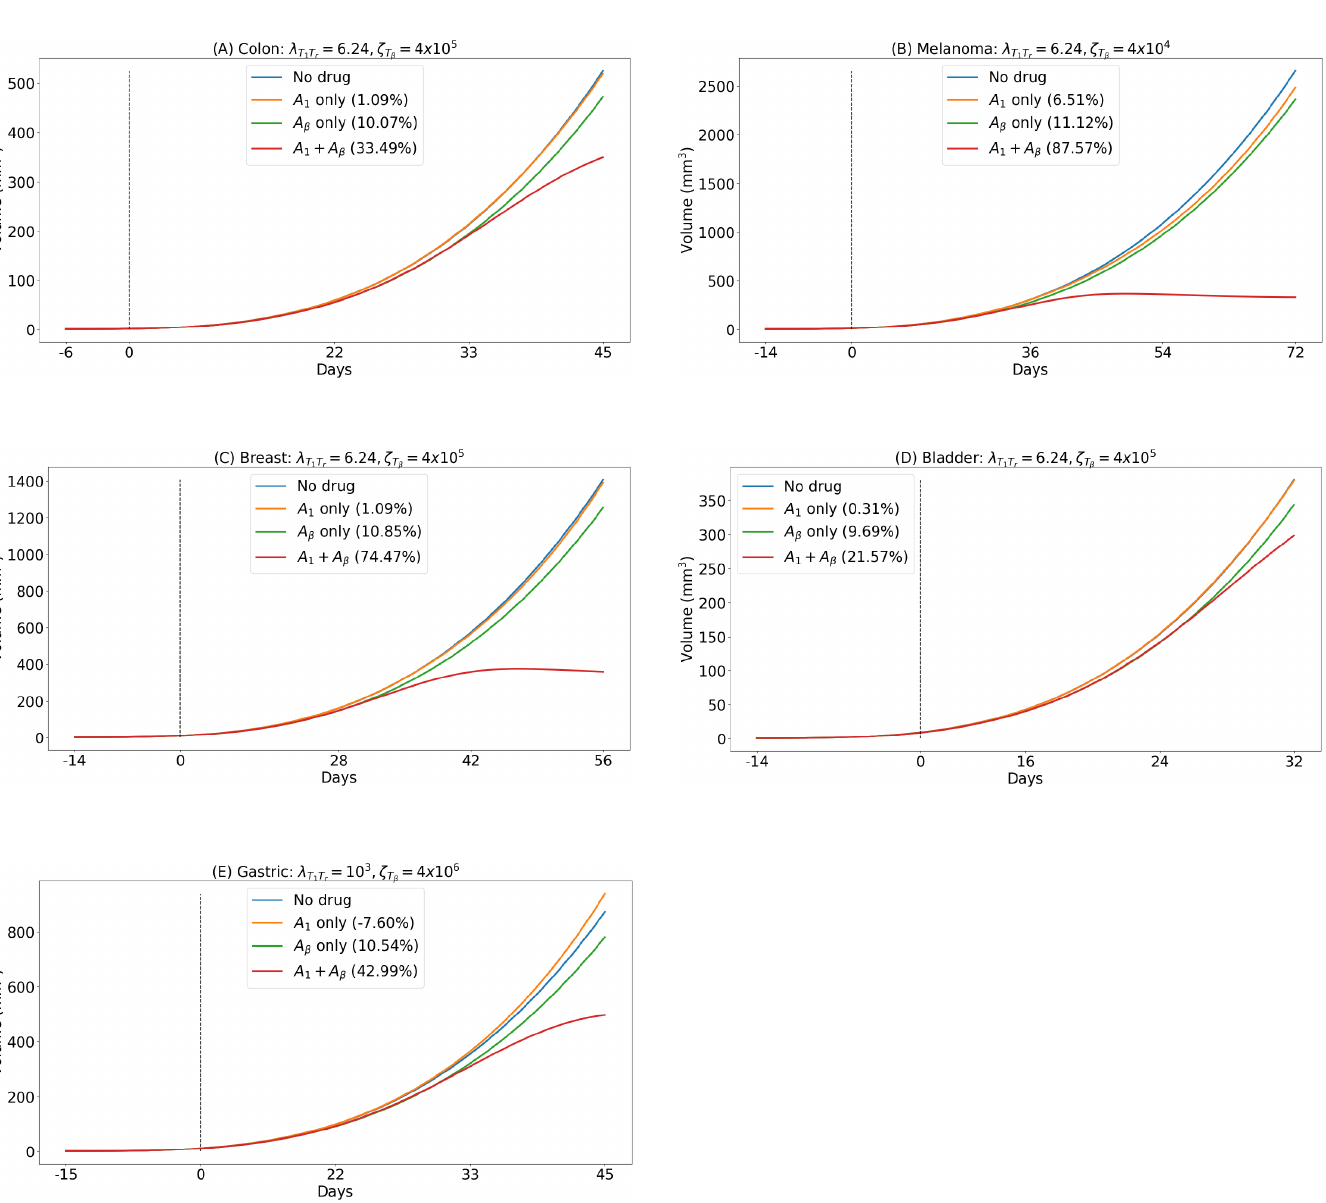
Fig 2. Tumor volume under various combinations with anti-PD-1 and anti-TGF- β . The “%” represents the difference, in volume, of treatment to no treatment, in percentage. All parameters are as in S1 File, with g ¼ 10 (cid:0) 8 g = cm 3 � d and g ¼ 2 � 10 (cid:0) 6 g = cm 3 � d . (A) Colon cancer: treatment starts at day 6 which corresponds to A 1 A b the schedule in [22]. (B) Melanoma cancer: treatment starts at day 14 as in [22]. (C) Breast cancer: treatment starts at day 14 as in [23]. (D) Bladder cancer: treatment starts at day 14 which corresponds to the schedule in [23]. (E) Gastric cancer: treatment starts at day 15 which corresponds to the schedule in [15].